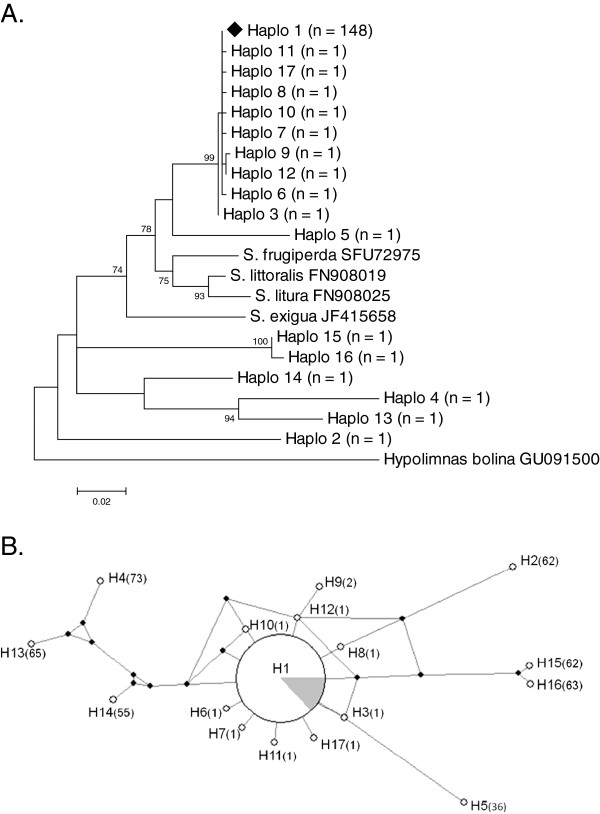
 3a: Maximum-Likelihood (GTR+R model) phylogenetic tree of the mtDNA COI gene, indicating the paraphyletic nature of the Spodoptera genus. Haplo1, the most common of the S. exempta haplotypes, is indicated by the solid diamond. The scale bar represents a 2% estimated difference in nucleotide sequence. Numbers given at each node correspond to the percentage bootstrap values (for 1000 repetitions). Replicate numbers of <60% were not included in the figure. The nymphalid Hypolimnas bolina is used as an outgroup, 3b: A network analysis displaying the skew and selection for mtDNA haplotype haplo1 (H1) within the S. exempta populations. The filled grey segment in the H1 pie-chart indicates the total percentage of Wolbachia infections in the samples, all found within haplo1 haplotypes. The most divergent haplotypes are found furthest from the centre, and brackets indicate the difference in nucleotide substitutions with haplo1. Filled circles indicate “missing” haplotypes in the evolutionary chain.